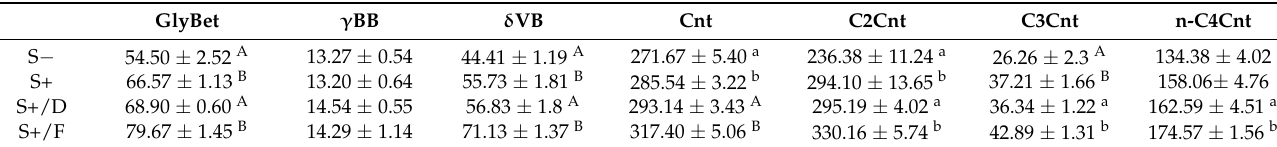
Table 4. Functional metabolites in buffalo meat in animal bred at 10 m 2 (S − ), at 15 m 2 (S+), and fed total mixed ratio (S+/D) or green forage (S+/F). Metabolites’ concentration (mg/Kg) is expressed as the mean ± ES. Statistical analysis was performed using t -test. Glycine betaine, GlyBet; γ -Butyrobetaine, γ BB; δ -Valerobetaine, δ VB; L-Carnitine, Cnt; Acetylcarnitine (C 2 Cnt); Propionylcarnitine (C 3 Cnt); Butyrylcarnitine (n-C 4 Cnt). GlyBet γ BB δ VB Cnt